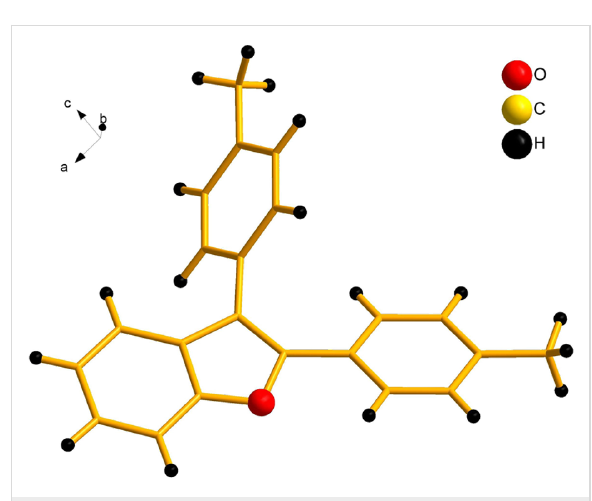
Figure 2: X-ray structure of bis-coupling product 3.1 (CCDC-1425338) [43].